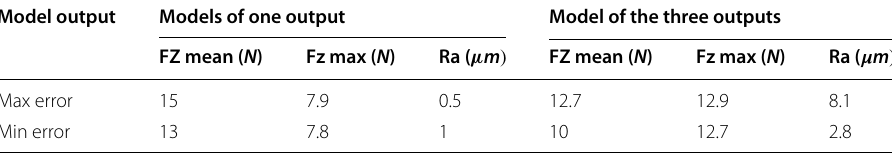
Table 4 The models error compared to the experimental results Model output